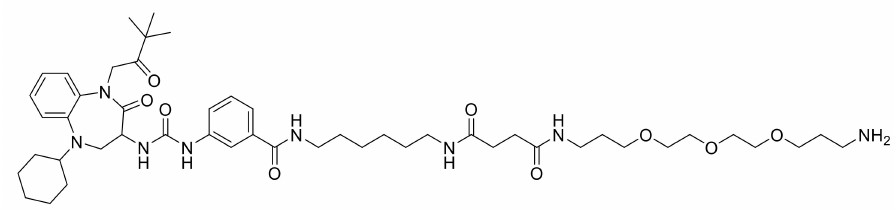
Figure 12. Chemical structure of 7 .